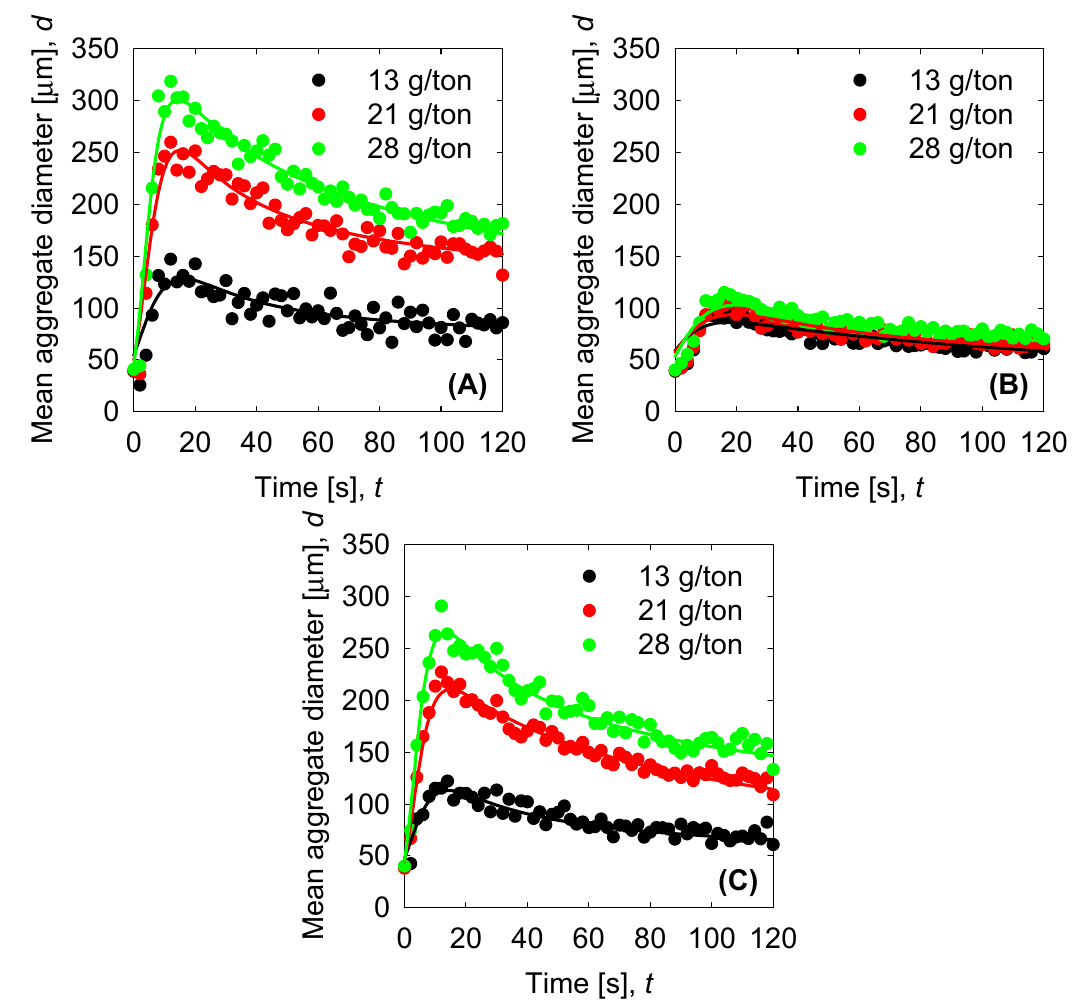
Figure 4. Flocculation kinetics of synthetic tailings in seawater as a function of flocculant doses (mixing rate 150 rpm). Solid circles correspond to experimental data and solid lines to the best fit with the population balance model (PBM). ( A ) Seawater (SW) pH 8. ( B ) SW pH 11. ( C ) Treated (T)-SW pH 11. Table 2. Quantitative results of GoF and R 2 when the PBM model is used.